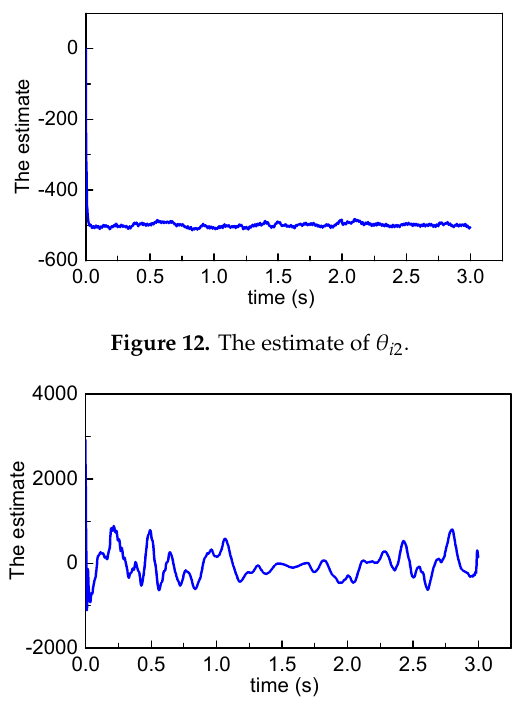
Figure 13. The estimate of θ i 3 .